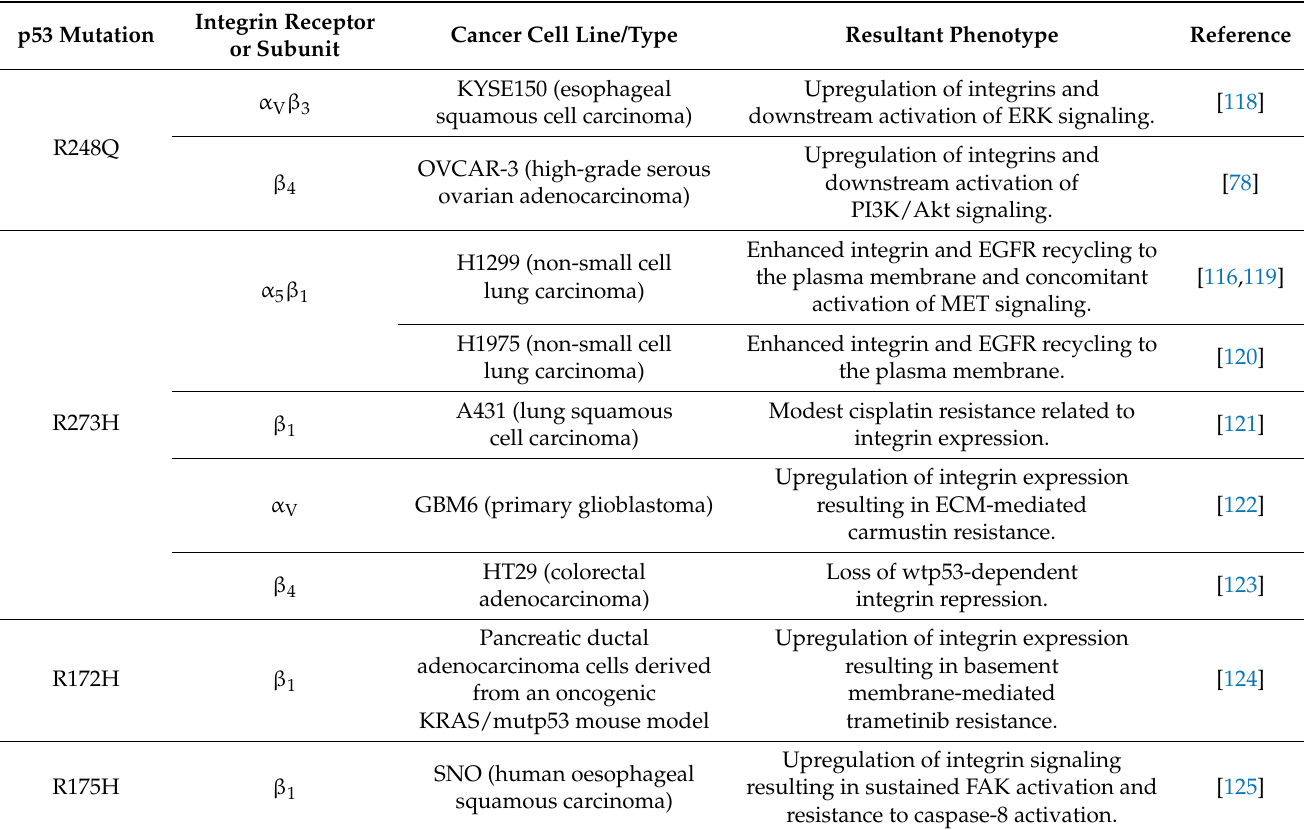
Table 2. Relationship between p53 mutations and integrin signaling in cancer